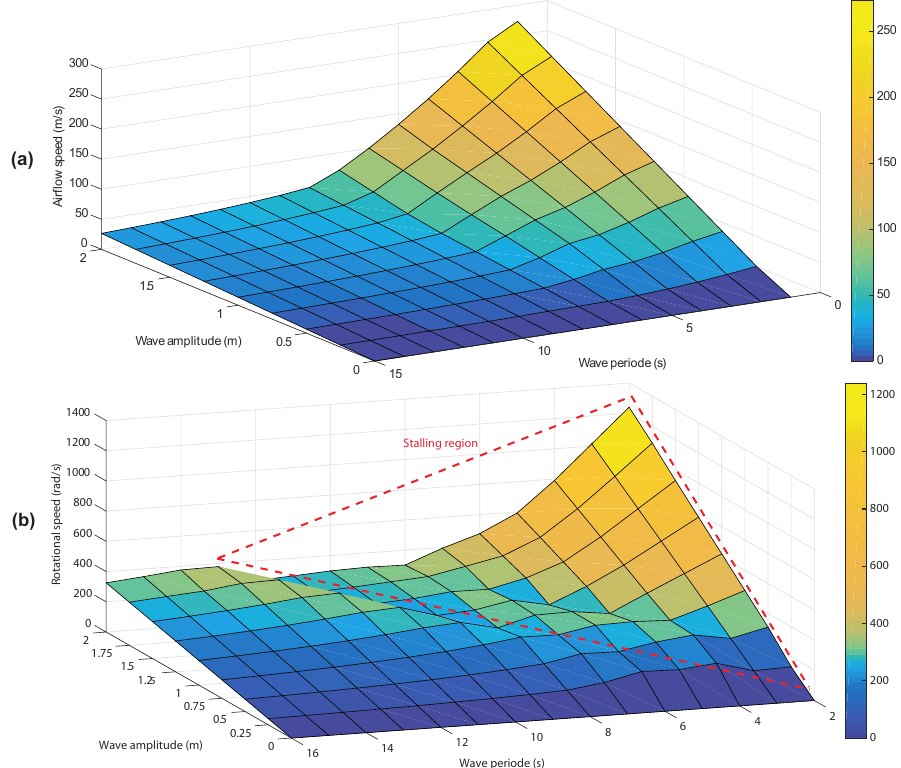
Figure 4. Variations for different waves. ( a ) Airflow speed. ( b ) Rotational speed.